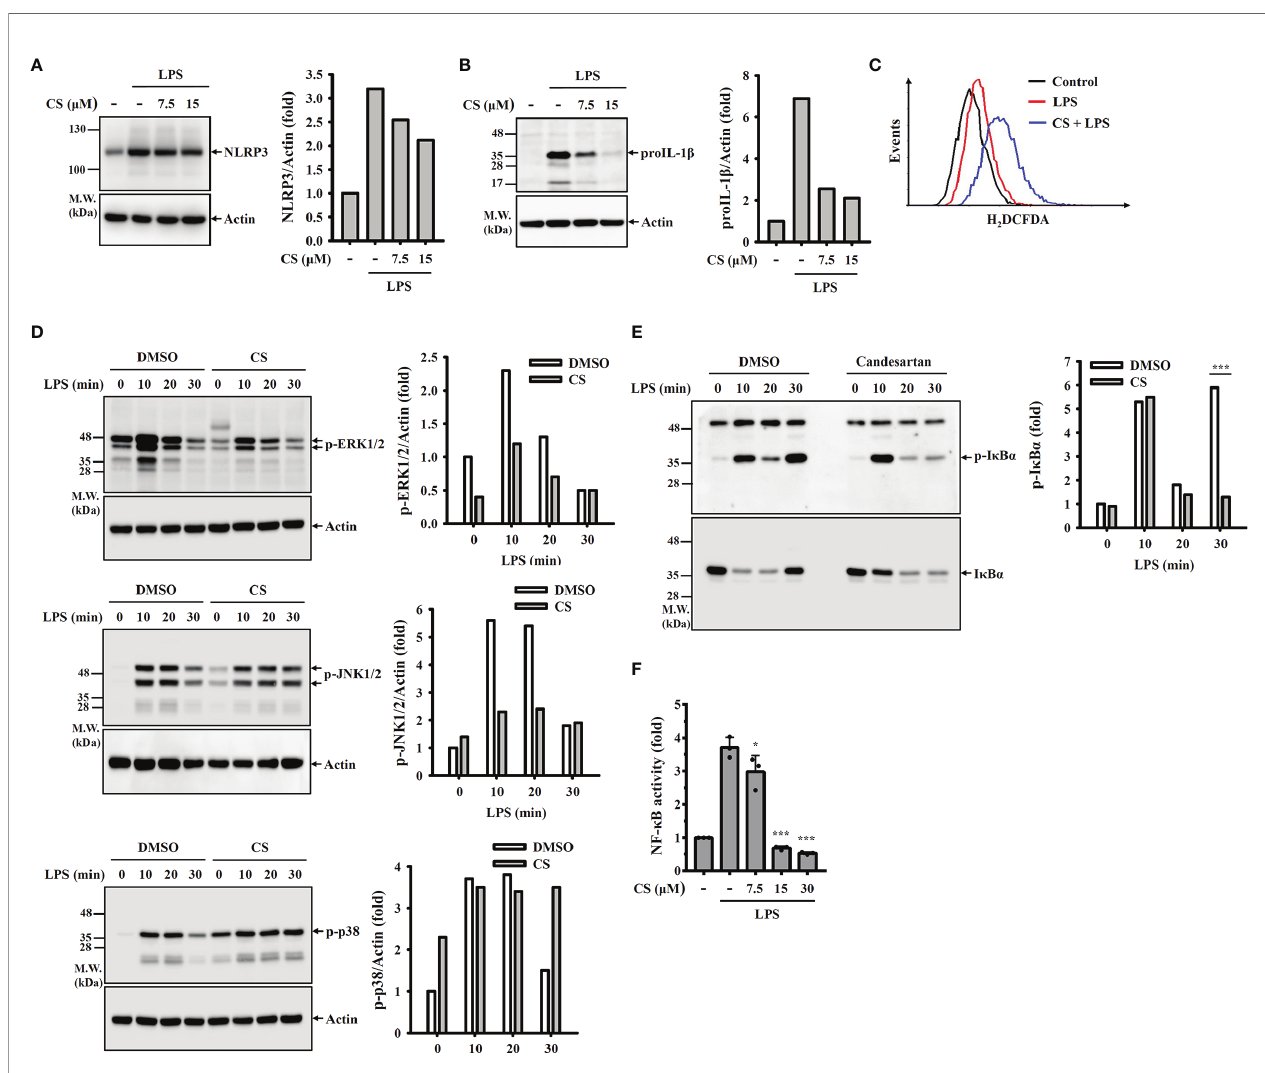
FIGURE 3 | CS inhibits NLRP3 and proIL-1 b expression by reducing NF- k B activation and MAPK phosphorylation. (A, B) J774A.1 macrophages were incubated with CS for 0.5 h followed by stimulation with LPS for 6 h The levels of NLRP3 (A) and proIL-1 b (B) in the cell lysates were measured by Western blot. (C) J774A.1 macrophages were incubated with CS for 0.5 h followed by stimulation with LPS for 0.5 h Intracellular ROS were measured by H 2 DCFDA staining. (D, E) J774A.1 macrophages were incubated with 15 µM CS for 0.5 h followed by stimulation with LPS for 0-30 min. The phosphorylation levels of ERK1/2, JNK1/2, p38 (D) , or I k B a (E) in the cell lysates were measured by Western blot. (F) J-Blue cells were incubated with CS for 0.5 h followed by stimulation with LPS for 24 h NF- k B transcriptional activity was measured by QUANTI-Blue. The Western blot images are representative results, and the histogram shows the band intensity. The NF- k B transcriptional activity data are expressed as the means ± SD of the three separate experiments. * and *** indicate a signi fi cant difference at the level of p <0.05 and p <0.001, respectively, compared to LPS-activated